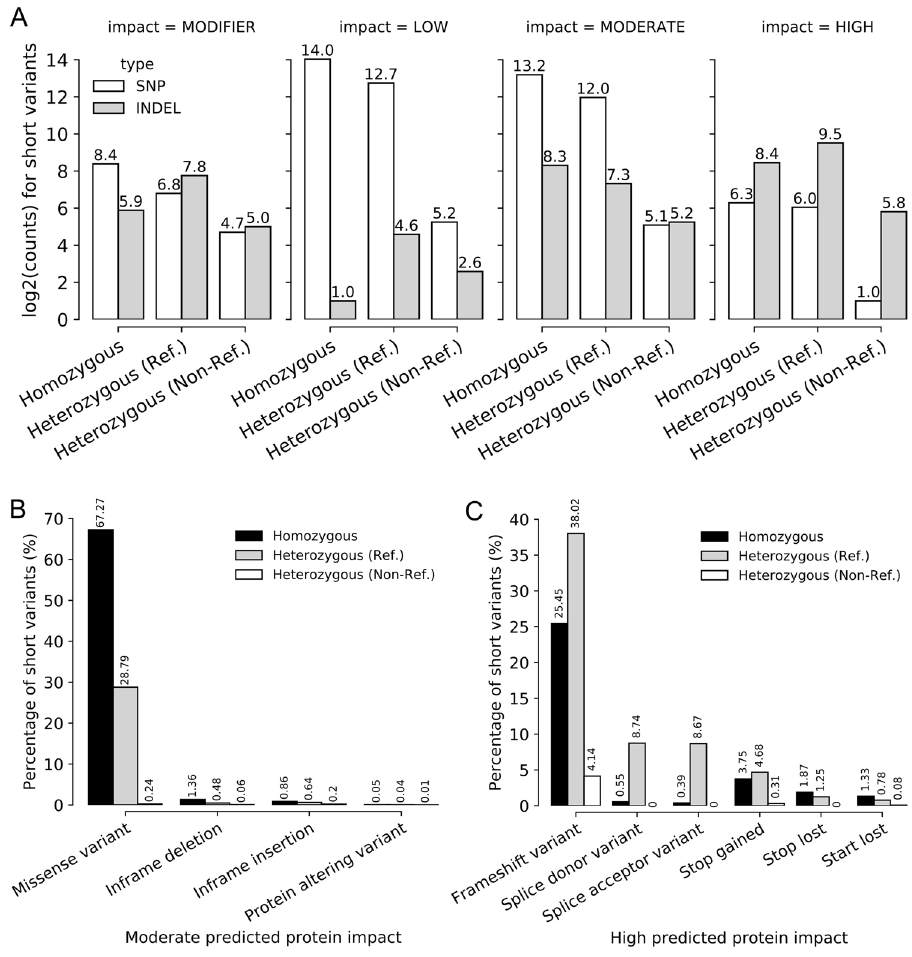
Figure 5. Homozygous missense and heterozygous frameshift variants are the major classes of short-variants with predicted moderate-to-high protein impact. ( A ) Barplots showing the overall number of variants (Y-axis) identified from RNASeq data for the SA-1 strain when compared to the R64-1-1 reference annotation for S. cerevisiae . The X-axis shows the ploidy identified for each variant: homozygous, heterozygous with reference, or heterozygous without reference. The columns are separated according to the overall level of predicted protein impact, from lowest to highest. ( B , C ) Barplot showing the breakdown of the predicted protein impacts (X-axis) and their associated proportions (Y-axis) for variants with moderate ( B ) and high ( C ) predicted protein